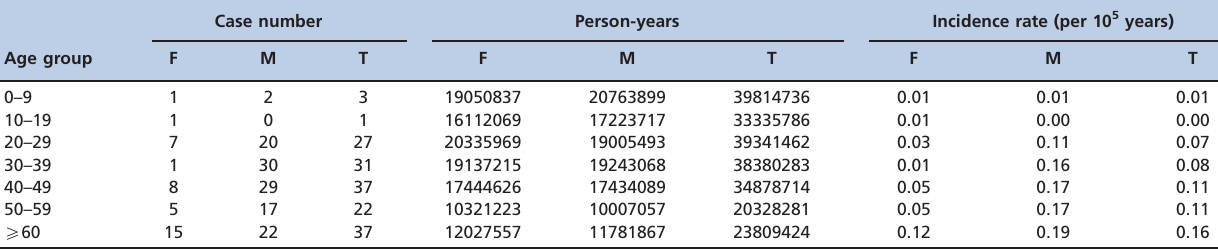
Table 1 - Age-specific incidence of thromboangiitis obliterans in Taiwan from 2002 to